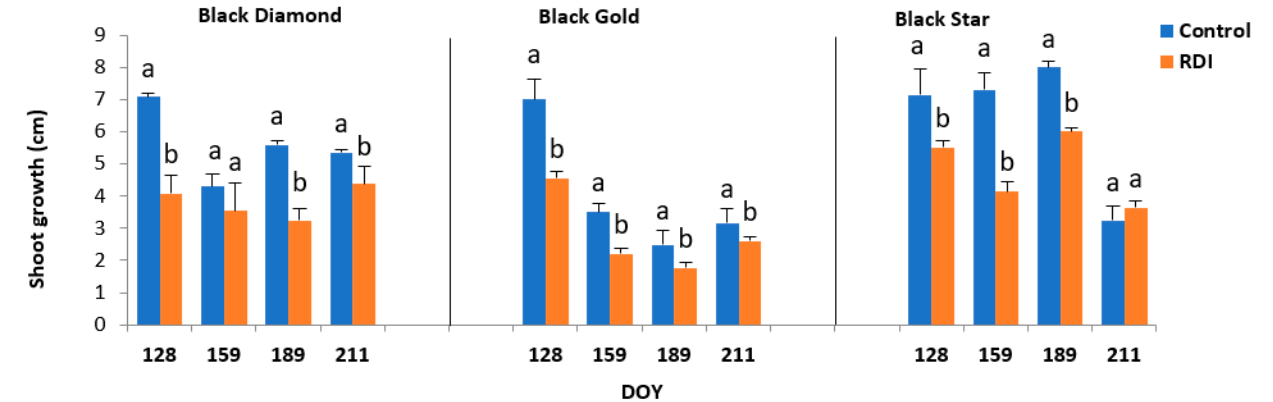
Figure 2. Shoot growth (cm) of three plums cultivars Black Diamond (BD), Black Gold (BG), and Black Star (BS) subject (Regulated Deficit Irrigation) or not (Control Irrigation) to deficit irrigation. Values are the means of twelve samples ( n = 12) ± standard deviation. The letters a and b indicate significant differences ( p ≤ 0.05) between the two irrigation treatments, within the same date.